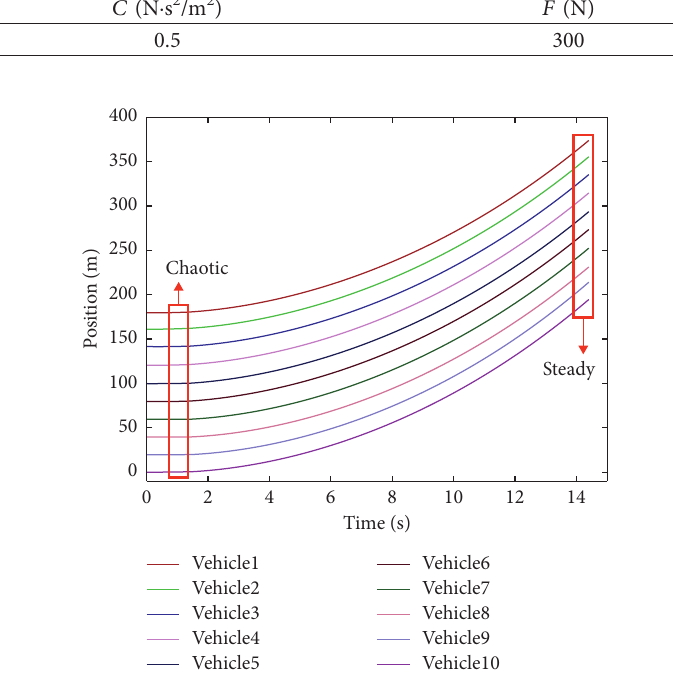
Figure 3: Position history under proposed controller (35).